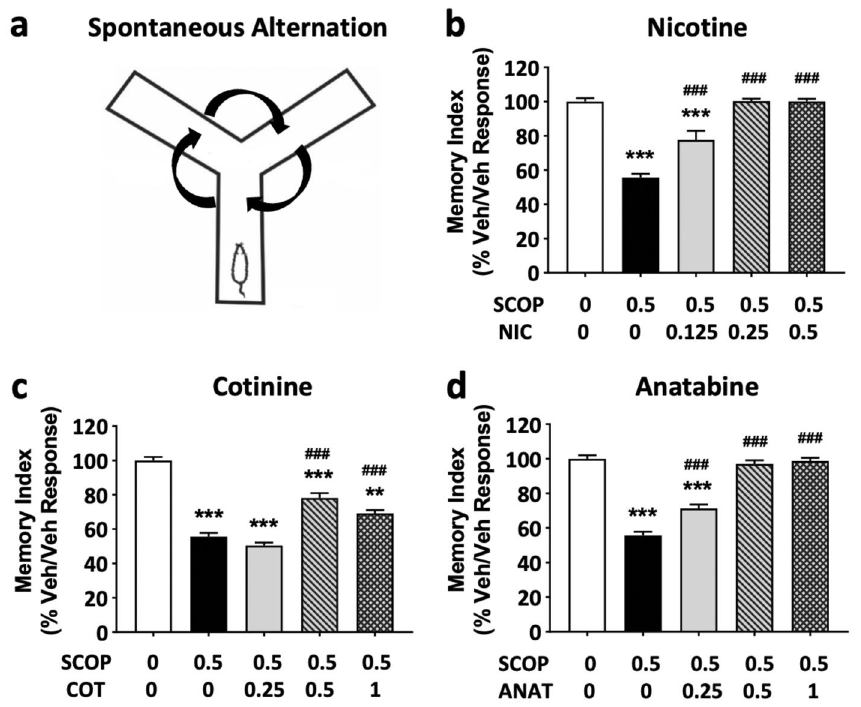
Figure 2. Effects of alkaloids on Y-maze working memory. ( a ) Schematic diagram of the Y-maze spontaneous alternation is shown. The test duration was 8 min. Memory indices, expressed as a percentage of vehicle response (Veh/Veh), are presented for ( b ) nicotine (NIC), ( c ) cotinine (COT), and ( d ) anatabine (ANAT). All compounds were able to significantly suppress scopolamine (SCOP)-induced memory deficit. Doses are indicated below each graph in mg/kg b.w. The vehicle in all panels are the same due to the fact all compounds were tested at the same time. **p < 0.01 and ***p < 0.001 compared with vehicle control without scopolamine (Veh/Veh; white bars). ### p < 0.001 compared with vehicle control with scopolamine (black bars). Grey bars are the lowest, bars with slashes are the medium, and checkered bars are the highest concentrations tested of the respective compounds. Data are expressed as mean ±